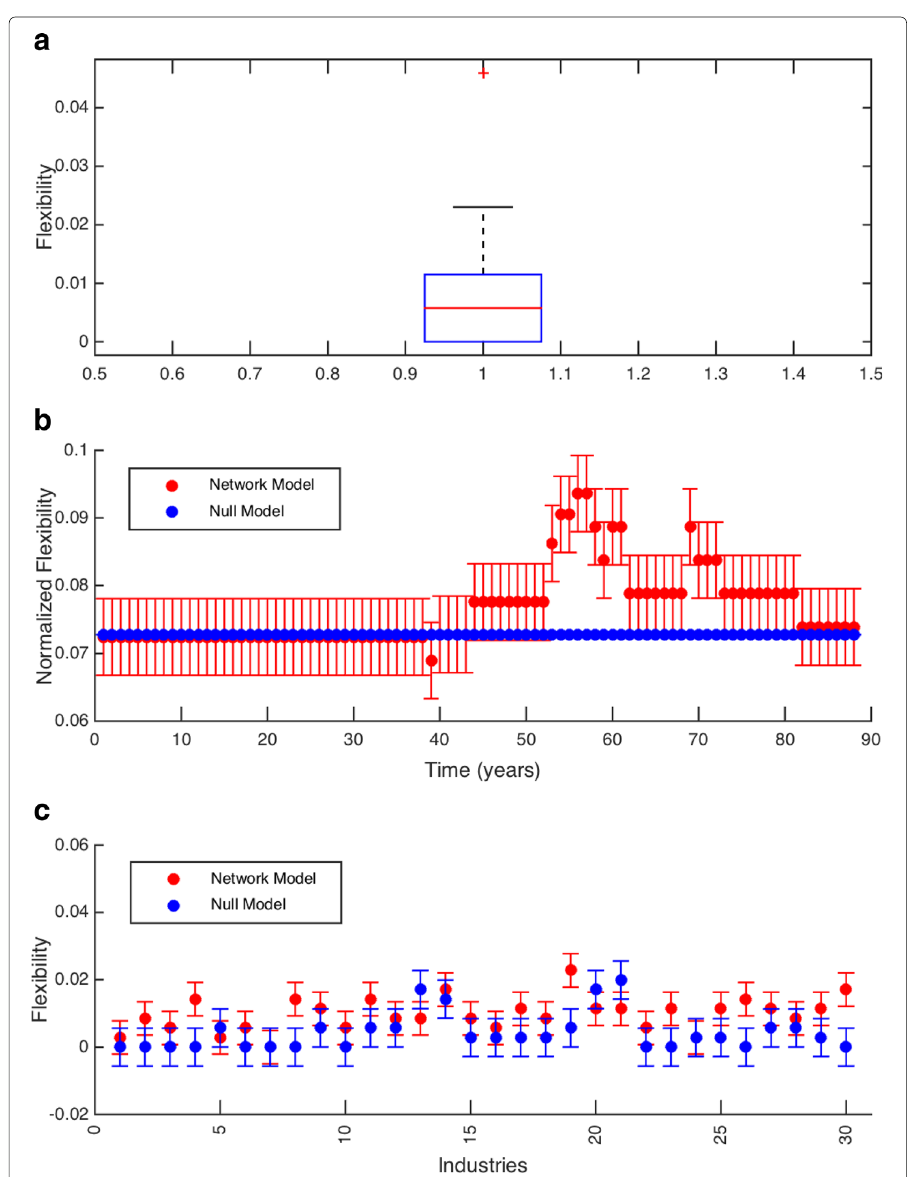
Fig. 3 FlexibilityofCommunitiesinMultilayerNetworks. a The box plot shows our estimate of the distribution of flexibilities for the entire data set, which is the total number of community changes through time. b The flexibility of the annual null matrix is 0, so all of the industries in the data set are more flexible than their counterparts in the null model, though one standard deviation below the mean for some of the industries fell below 0. The differences observed between the network and null matrix flexibilities were highly significant ( p = 2.5 × 10 − 4 ) . These statistical tests indicate that the temporal variation in mesoscale network structure that we observe in industry stock returns is non-trivial. c The quarterly flexibilities are much more variable in both the network matrix and the null matrix. Some industries in the network matrix are more flexible than their counterparts in the null matrix e.g., Pharmaceuticals, Oil and Gas, Wholesale, and Business Equipment, and others are less flexible. The differences observed between the network and null matrix flexibilities were also highly statistically significant ( p = 8.4 × 10 − 5